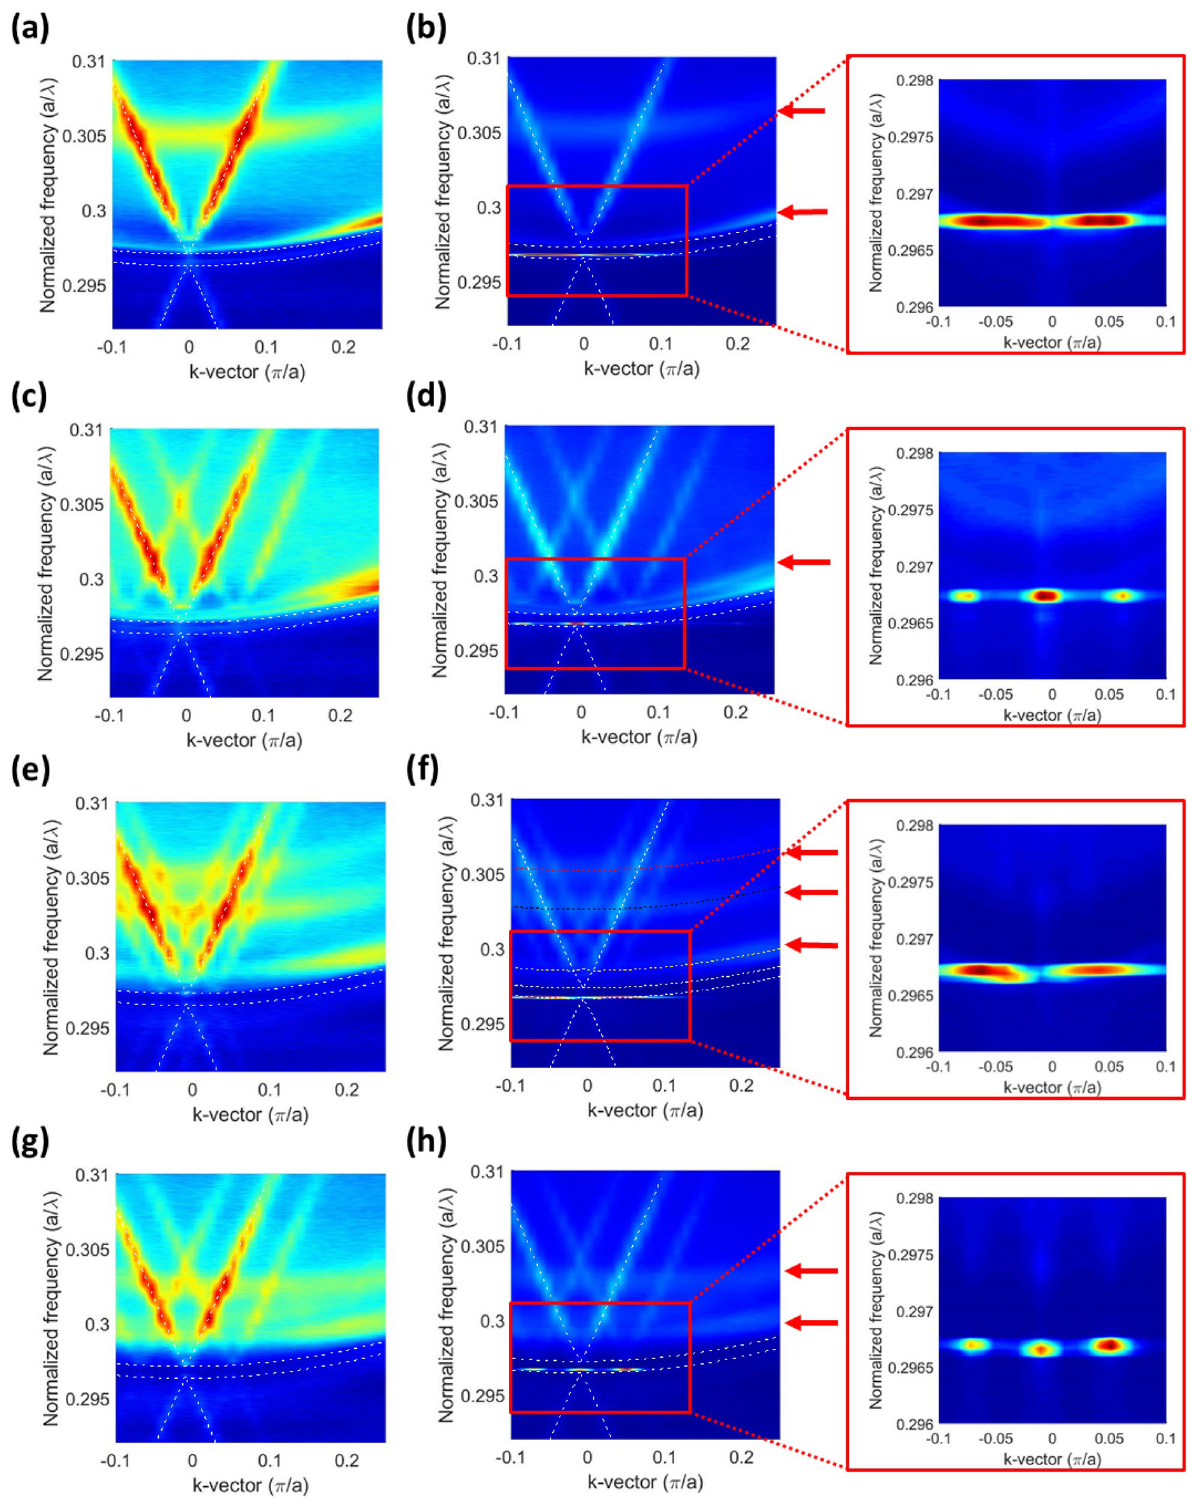
Figure 5. The photonic band structures measured by angle-resolved electroluminescence. ( a ) and ( b ) represents the PC band structures measured along the x direction (directions defined in Fig. 1) of the PCSEL without grating structure driving below (0.8 × I th ) and above (1.2 × I th ) threshold conditions, respectively. ( c ) and ( d ) display the PC band structures of the VIDG-PCSEL with 0° grating measured along the y direction. ( e ) and ( f ) show the PC band structures measured along the x direction of 30° grating device below and above threshold, respectively and ( g ) and ( h ) show the photonic band structures of the same device of ( e ) measured along the y direction. The insets show the magnified lasing modes around the Γ point of each band structures. The dashed lines represent the PC band structures of the square lattice and guided modes as detailed in the supplementary